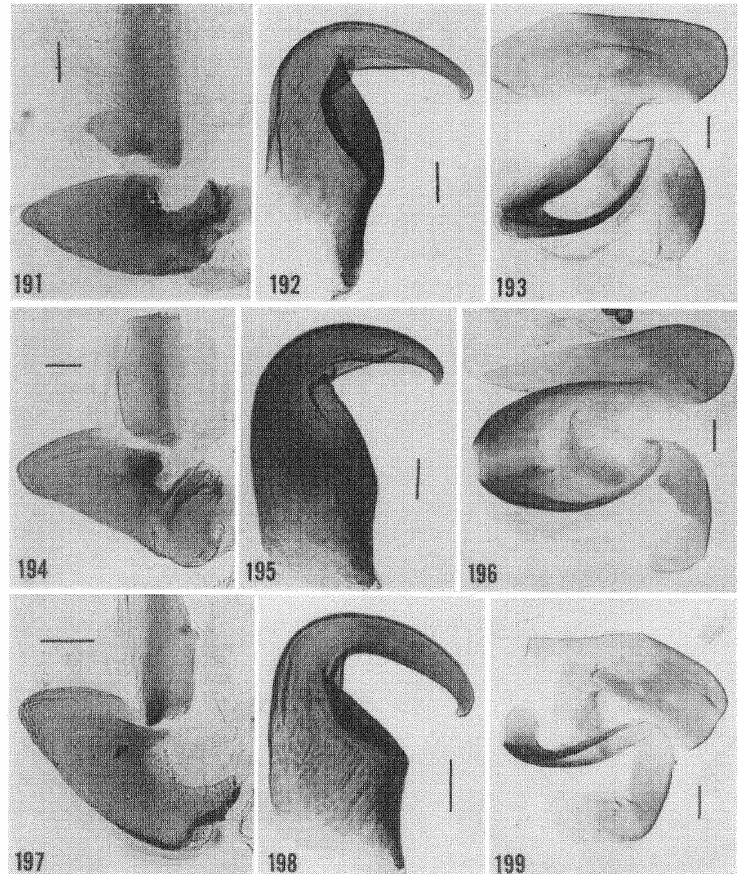
Figures 191-199. Male genital phallomeres of Derocalymma spp. 191- 196. D. porcellio. 191-193. (1416 L). (from sho.wn in Fig. 165). 194- 196. (167 ANSP). Tendaguru, Lindi, German East Africa (det. Hebard). 197-199. (1411 L). D. silphoides (from shown in Fig. 166). (scale 0.1